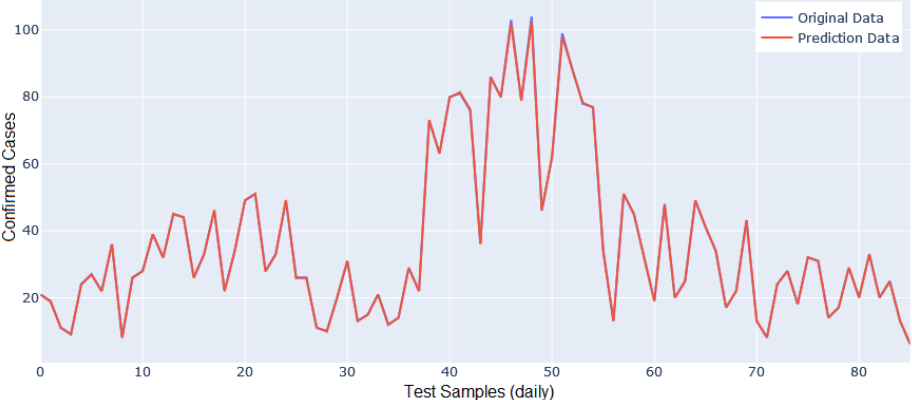
Figure 11. Prediction accuracy comparison between actual and predicted data using AQIoT-2 test dataset (blue, original values; red, predicted values).